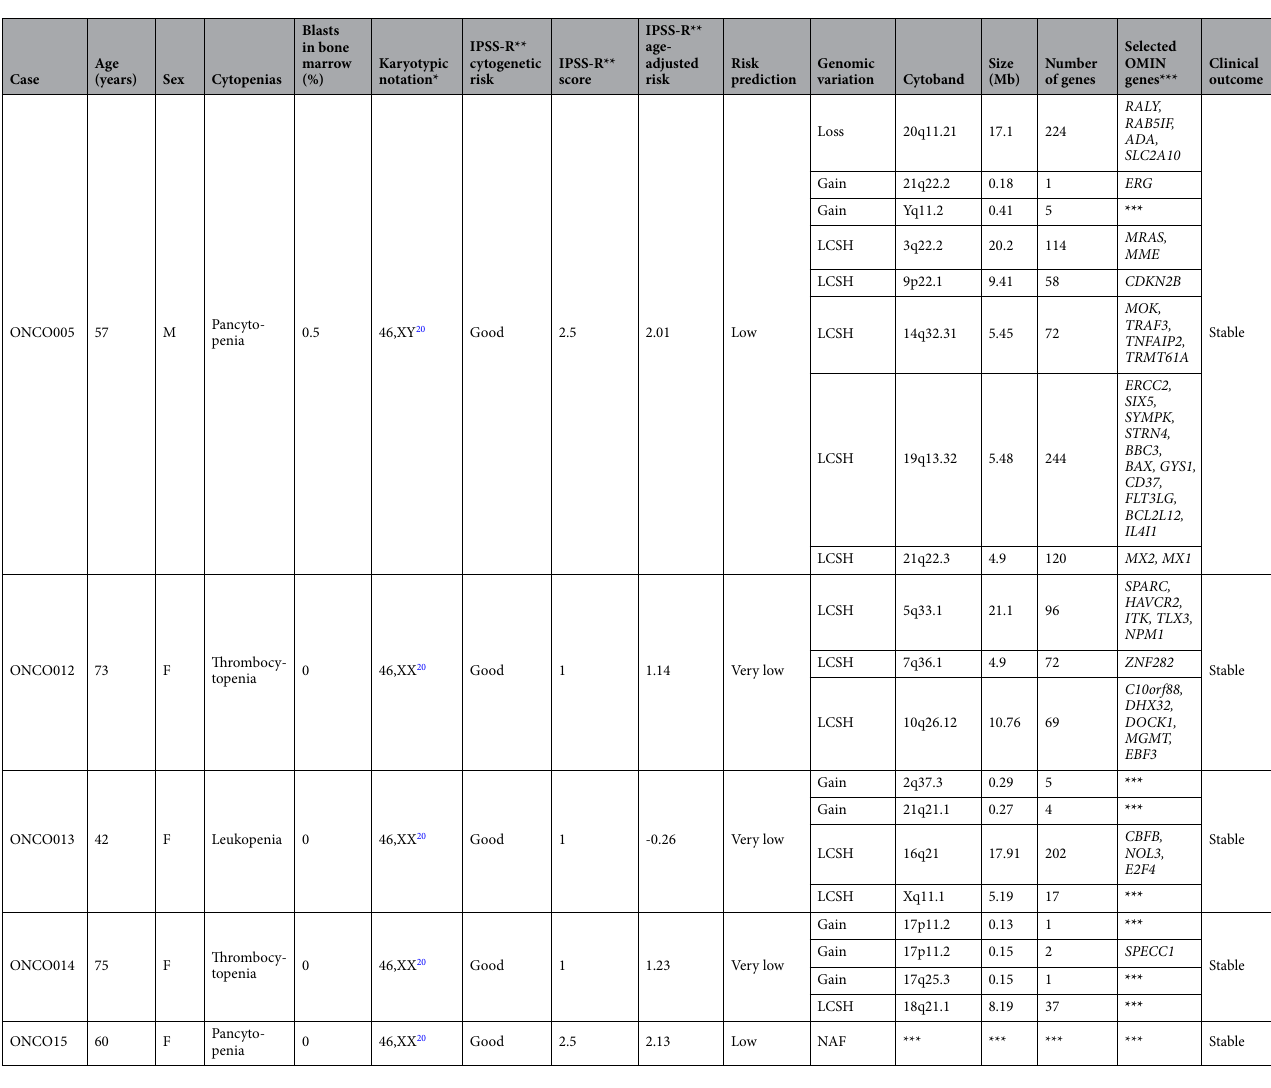
Table 1. Clinical features, cytogenetic and cytogenomic results, and risk estimates (according to the International Prognostic Scoring System—Revised) of a cohort of patients with myelodysplastic syndrome in addition to clinical outcomes. F female, M male, NAF no alterations found, LCSH long continuous stretches of homozygosity. *ISCN2016: an international system for human cytogenomic chromosome